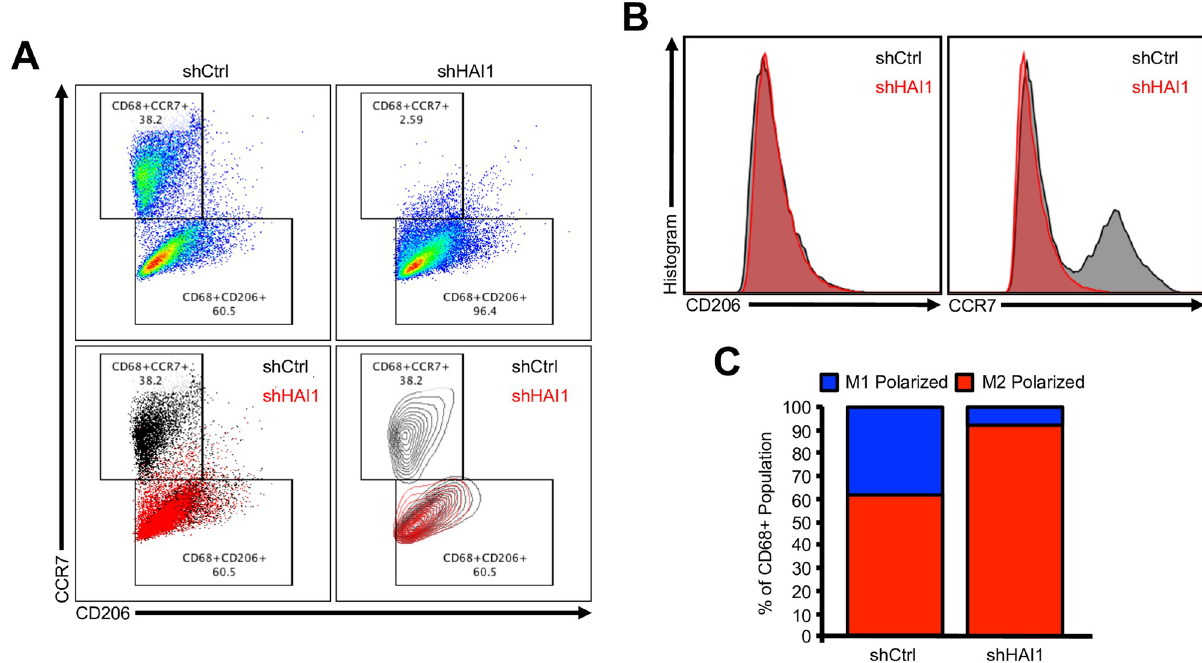
Fig 3. Epithelial loss of HAI-1 leads to impaired M1 macrophage polarization in vitro . (A) H358 human lung adenocarcinoma were transfected with either a scramble shRNA control vector (shCtrl), or shRNA against HAI-1 (shHAI-1). Conditioned media was collected and transferred to non- polarized (M0), THP-1-induced macrophages. After 48 hours, THP-1-induced macrophages were allowed to recover in control media for another 48 hours and analyzed by flow cytometry for the macrophage surrogate CD68, the M1 polarization marker CCR7, and the M2 polarization marker CD207. (B) Histogram plot showing the relative expression of CD206 or CCR7 in THP-1-induced macrophages cultured media from either shCtrl or shHAI-1 H358 cells. (C) Relative fraction of THP-1-induced macrophages displaying an M1 or M2 polarized phenotype following incubation in conditioned media from wither shCtrl or shHAI-1 H358 cells.